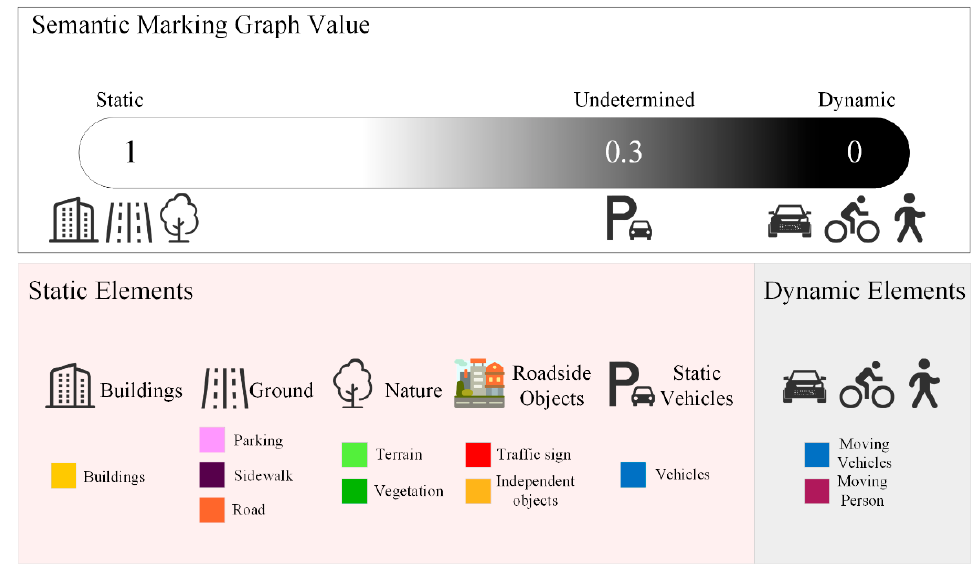
Figure 6. Classification of environmental elements based on prior knowledge. Semi-dynamic environmental elements usually have the following